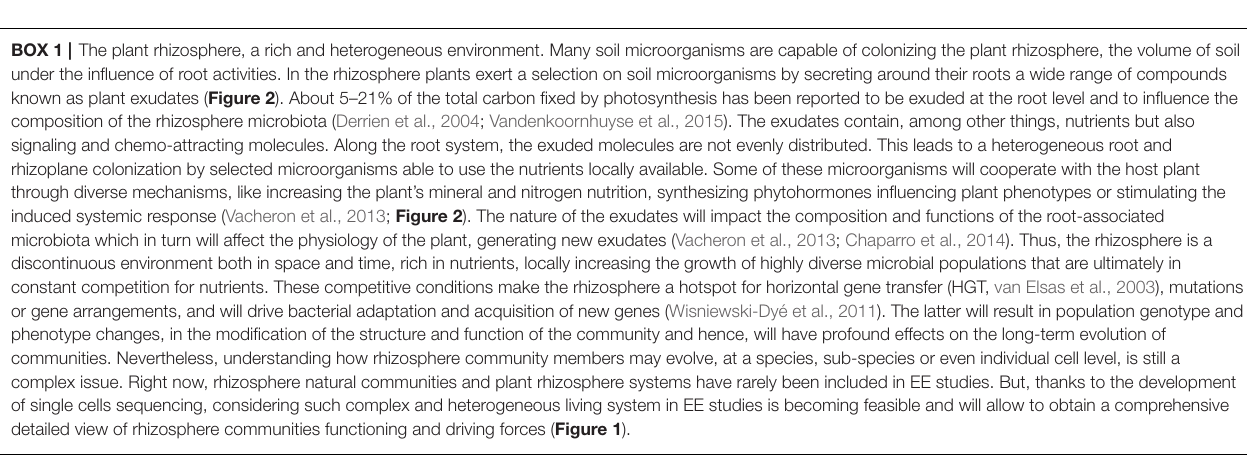
FIGURE 2 | Relationships between plant and microbial components. (A) Plants interact with a wide diversity of microorganisms (microbiota) in the different compartments of the plant system. The rhizosphere corresponds to the soil zone where the roots impact the soil organization and microbial functioning, while the rhizoplane is the interface between the root surface and the soil. The phyllosphere corresponds to the surface of all the aerial organs of the plant. Root exudates attract or repel soil microorganisms toward roots and increase the growth of myriads of microorganisms that will interact between each other (positive, negative or neutral biotic interactions). (B) Major biotic interactions in the rhizosphere include plant-microorganism interactions and microorganism/microorganism interactions, involving the exchange of different classes of molecules (hormones, toxins, virulence factors, signals, etc.).